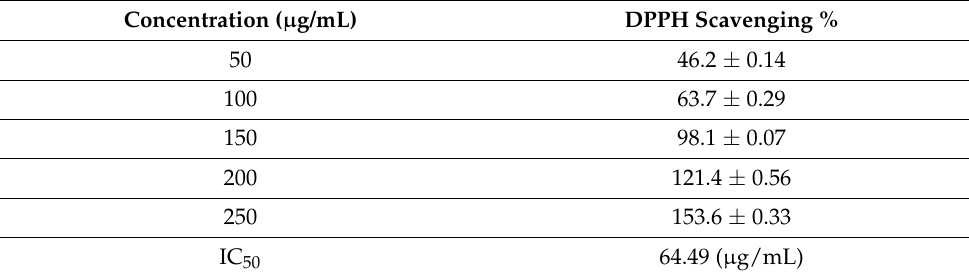
Table 4. Antioxidant activity of